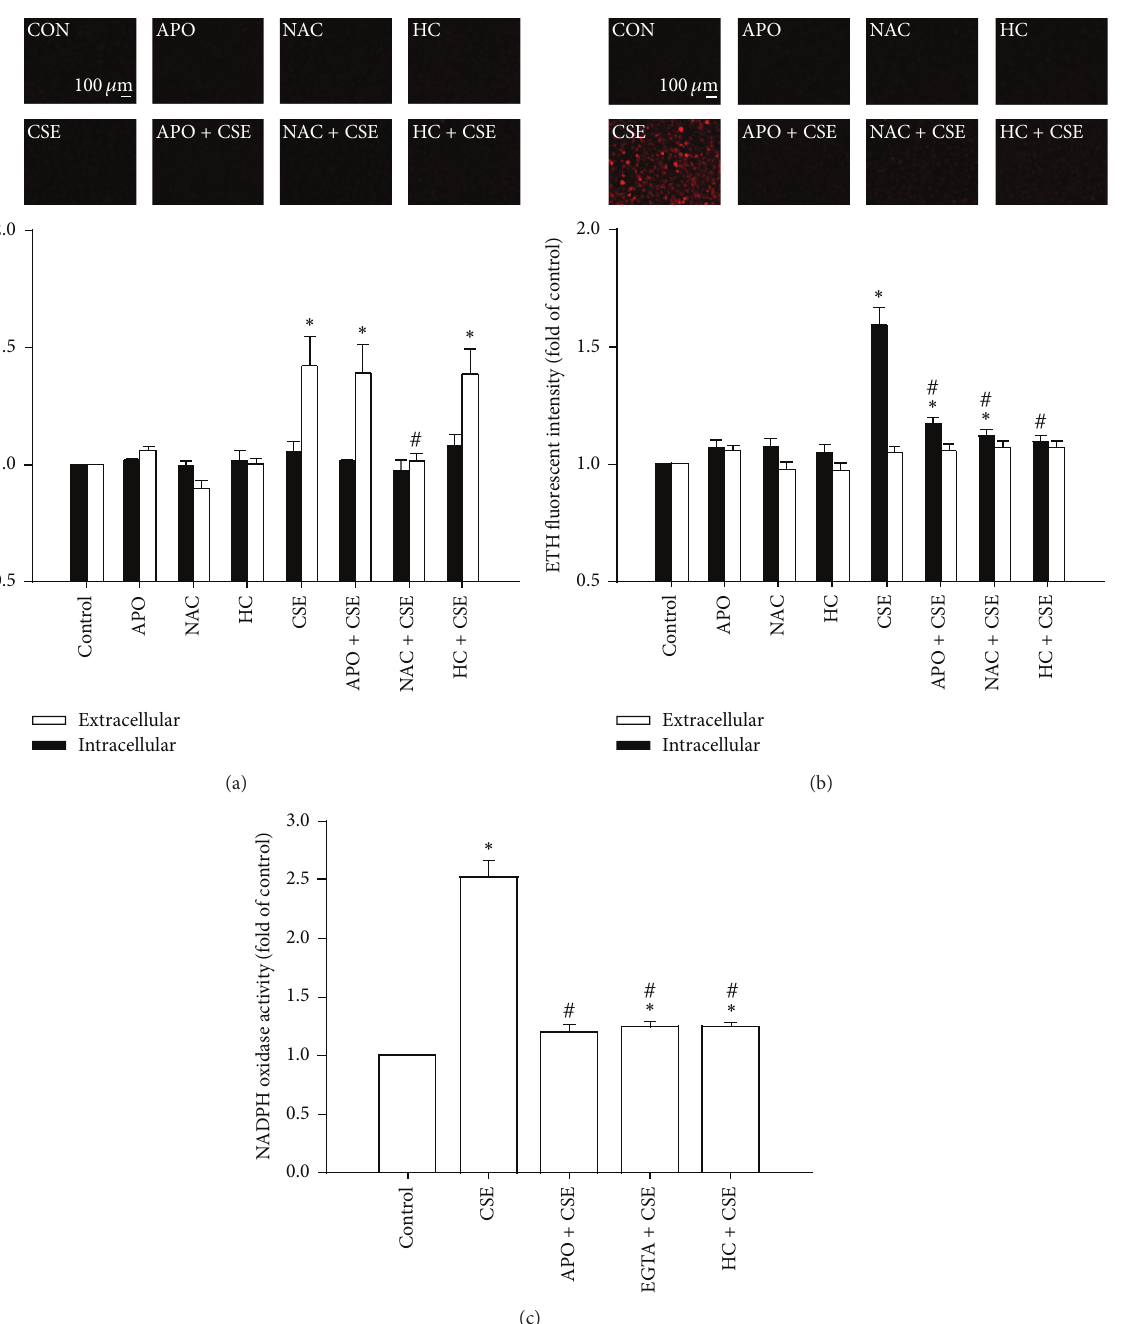
Figure 4: The CSE-induced extracellular ROS stimulate TRPA1 to Ca 2+ -dependently increase intracellular ROS via NADPH oxidase in HBECs. (a–c) Cells were exposed to medium alone or to 3% CSE for 2, 30, and 15 min, respectively, after pretreatment with apocynin (APO; an inhibitor of NADPH oxidase; 150 𝜇 M), after pretreatment with N-acetyl-cysteine (NAC, a ROS scavenger; 1mM), after pretreatment with HC-030031 (HC, a TRPA1 antagonist; 9 𝜇 M), or after pretreatment with EGTA (an extracellular Ca 2+ chelator; 500 𝜇 M). Levels of ROS were measured by HE fluorescent probe assay. NADPH oxidase activity was measured by NADP + /NADPH assay. Data in each group are mean ± SEM from five independent experiments. ∗ 𝑝 < 0.05 versus the control; # 𝑝 < 0.05 versus CSE